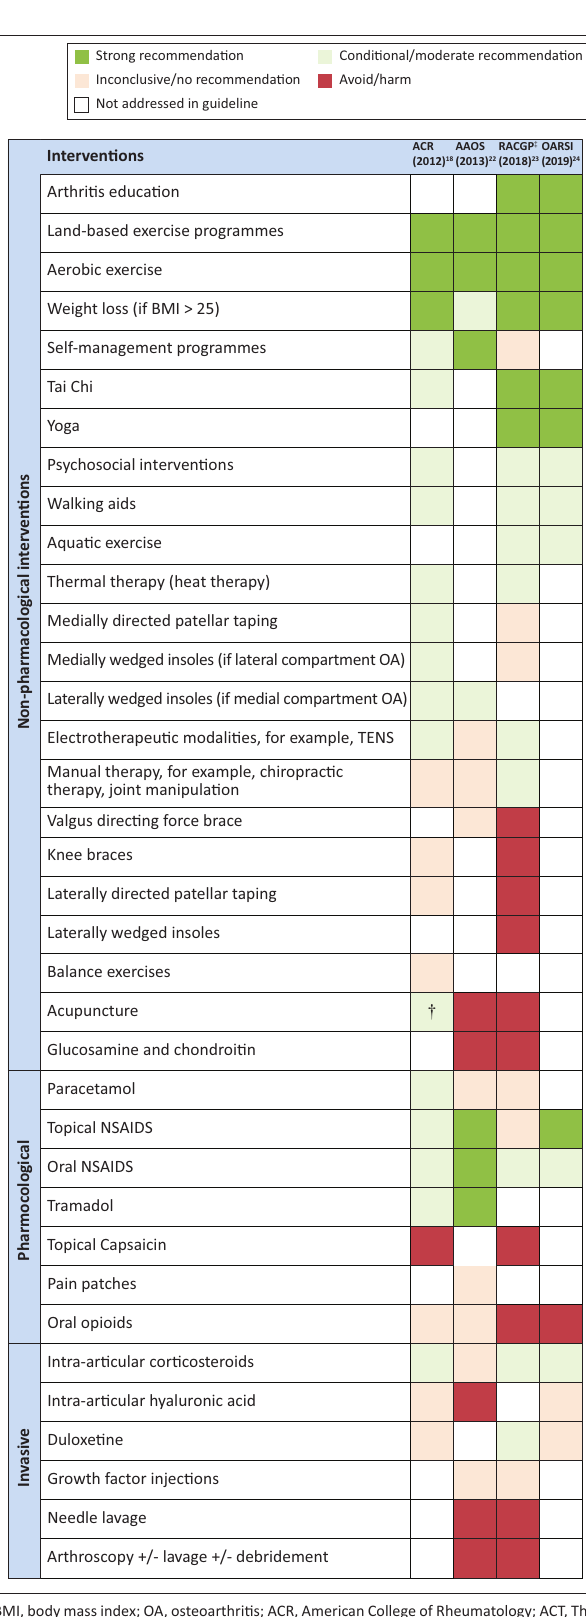
FIGURE 4: Summary of international recommendations for knee osteoarthritis